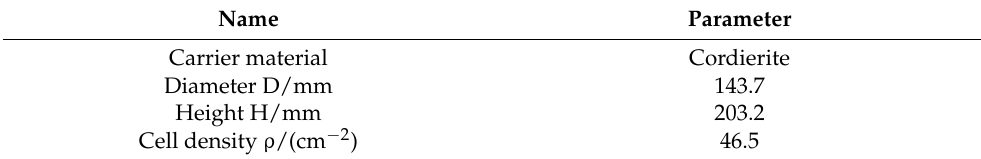
Table 3. DPF parameters.